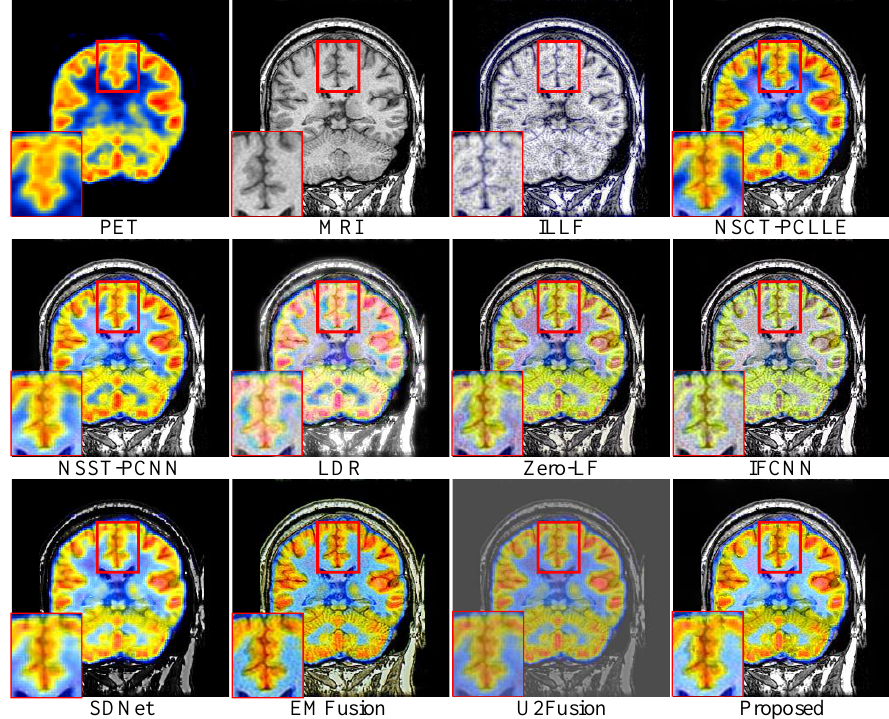
Figure 6. Comparison of performances of various methods on the positron emission tomography (PET)-MRI source images. For a clear comparison, we select a same region (i.e., the red box) in each image and zoom in it in the bottom left corner.